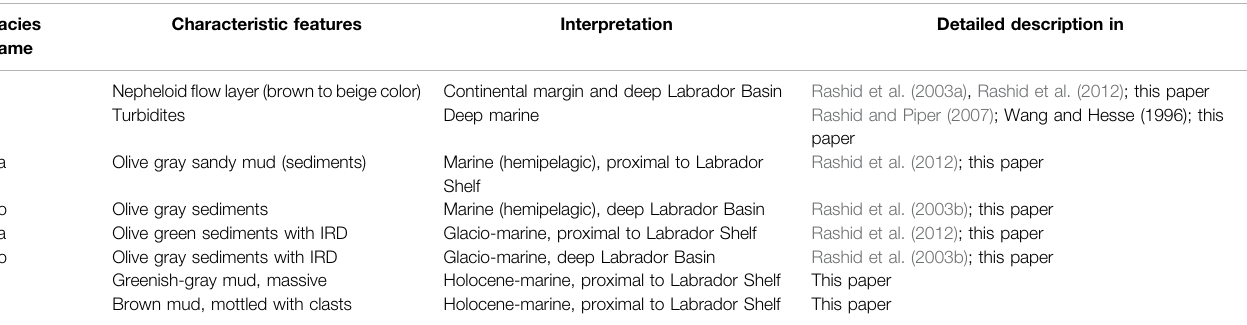
TABLE 2 | Sediment facies identi fi ed and used in the